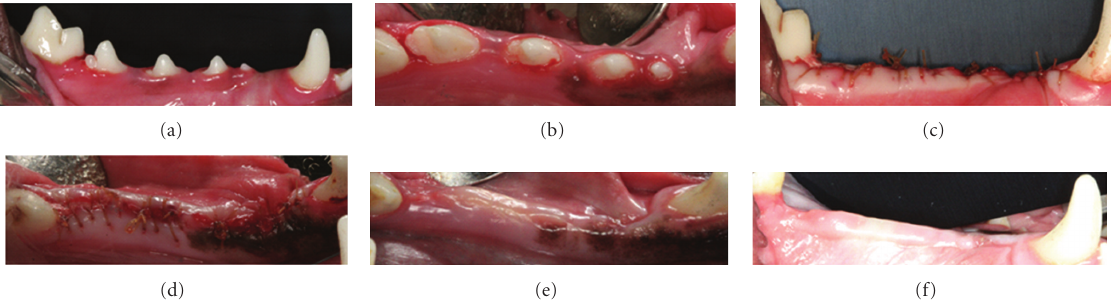
Figure 1: Representative images of preextraction (a) and (b), immediate postextraction (c) and (d), and six-week postextraction healing (e) and (f). Complete closure of extraction sockets and lack of clinical signs of inflammation are evident.